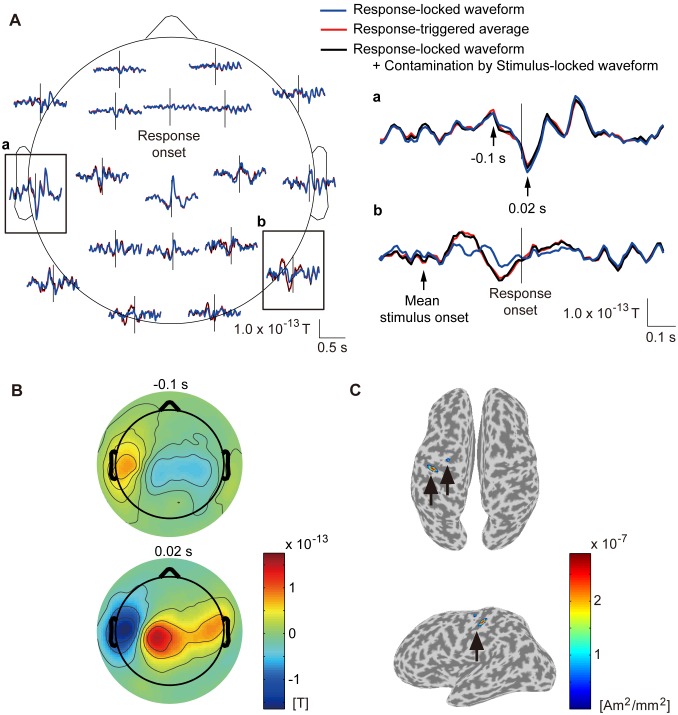
Response-locked waveform (subject 8).
A: Time course of response-locked waveform. Blue and red lines represent response-locked waveform and response-triggered average. Black lines represent response-locked waveform contaminated by stimulus-locked waveform. Vertical lines represent response onset. Framed plots are enlarged on the right (a and b). B: Spatial patterns of response-locked waveform at −0.1 s (upper) and 0.02 s (lower) after response onset. C: Current sources estimated from response-locked waveform. Powers averaged across time from −0.25 s to 0.25 s after response onset are shown. Other subjects show similar results.